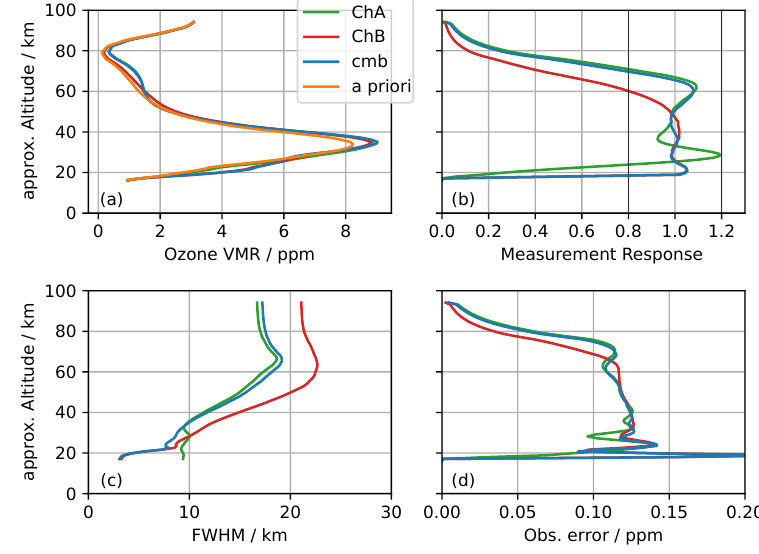
Figure 3. Ozone retrieval for three different spectra: ChA only, ChB only, and combined (cmb). Shown are the ( a ) ozone VMR, ( b ) the measurement response, ( c ) the full width at half maximum of the averaging kernels, and ( d ) the estimated observational